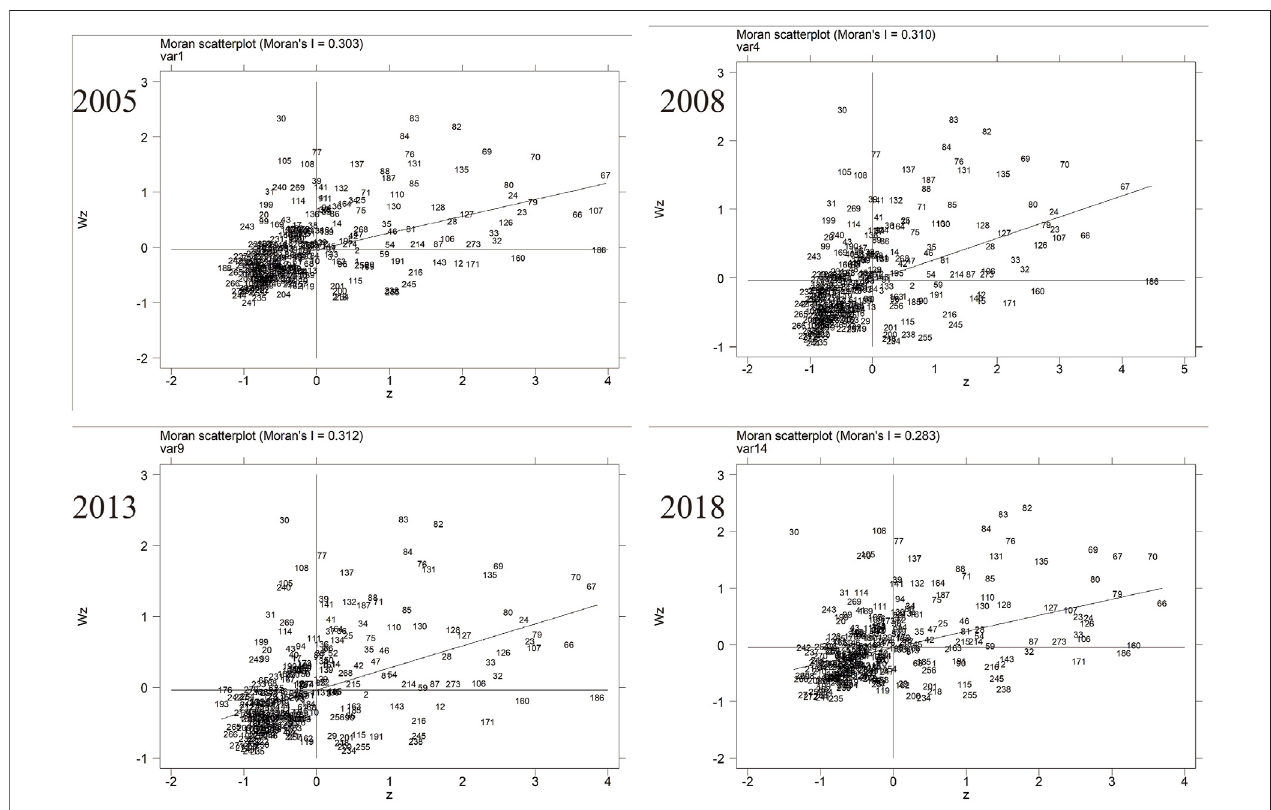
FIGURE 1 | Moran ’ s I scatter plot of urban consumption in 2005, 2008, 2013, and 2018.